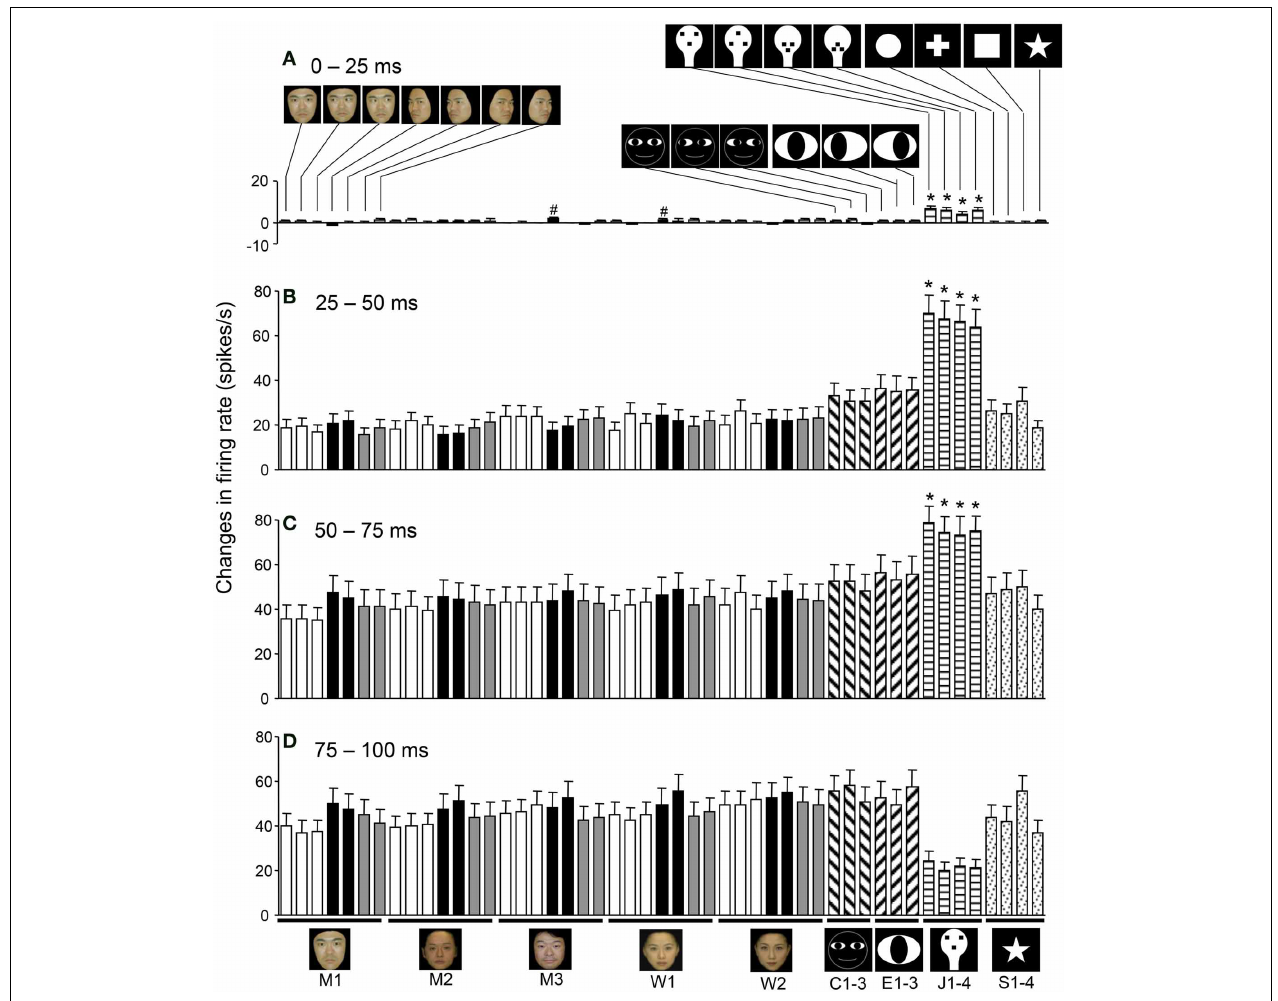
FIGURE 8 | Temporal changes in the mean response patterns of the 112 visually responsive neurons across the different epochs. (A) Comparison of the response magnitudes to the 49 visual stimuli in epoch 1. In epoch 1, the face-like patterns (J1–4) elicited stronger responses than the other visual stimuli, except for the 2 stimuli indicated by # (Tukey tests after One-Way ANOVA, p < 0 . 05). (B) Comparison of the response magnitudes toward the 49 visual stimuli in epoch 2. In epoch 2, the response magnitudes to all visual stimuli increased compared to